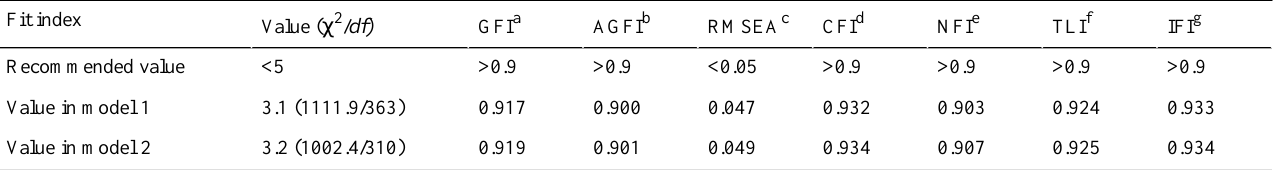
Table 4. Research model